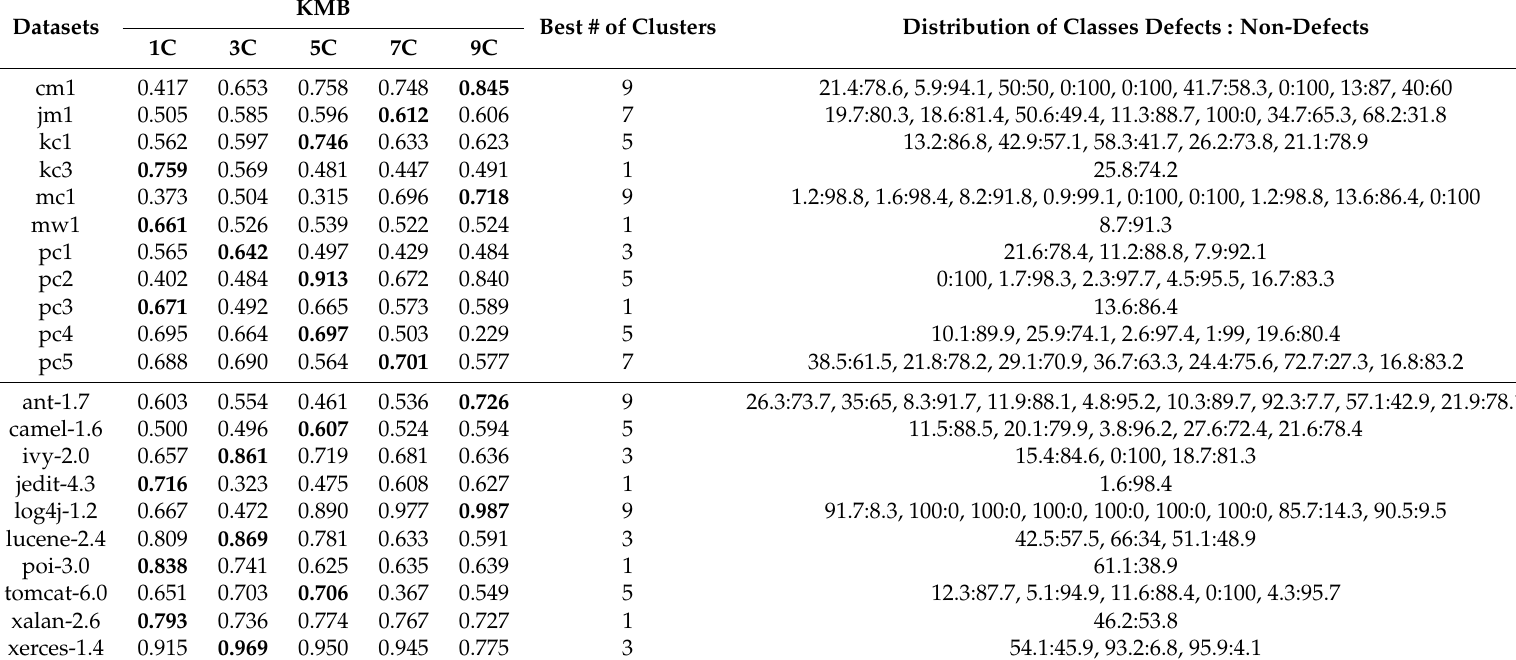
Table 4. G-mean results of two-folds cross-validation for the proposed approach based on the ensemble